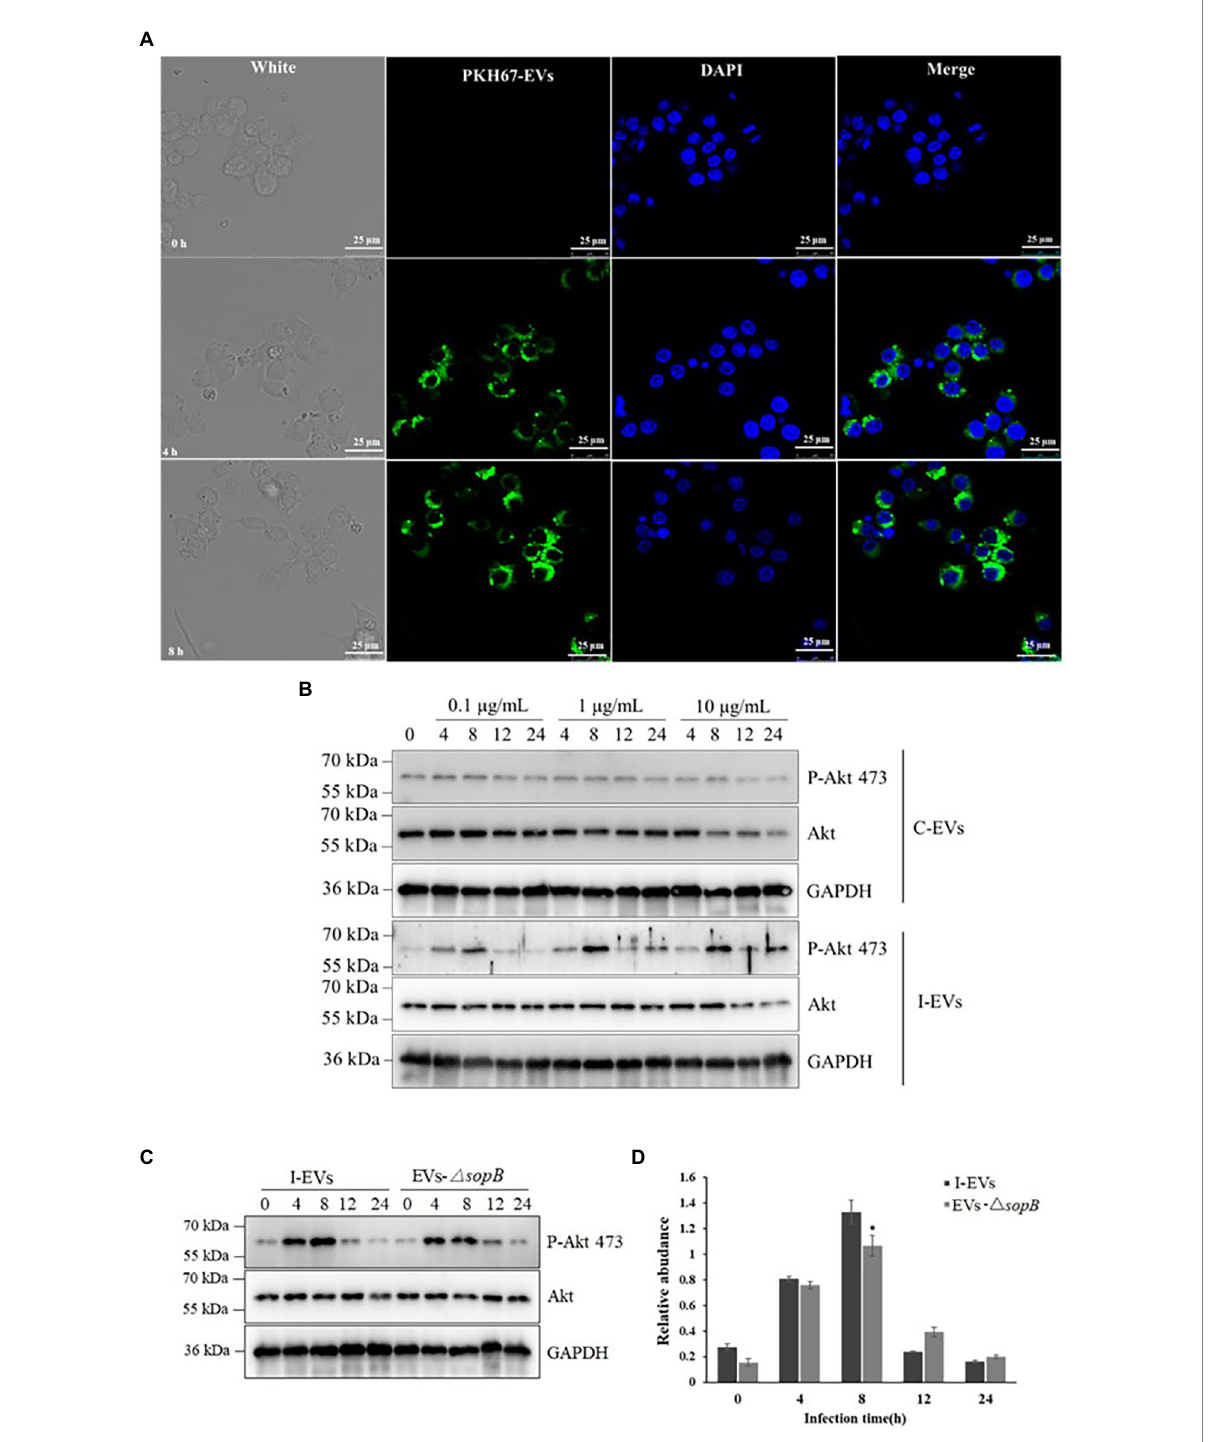
FIGURE 4 Functional verification of extracellular SopB taken up by RAW264.7 macrophages. (A) The RAW264.7 macrophages were incubated for 4 and 8 h ( n = 3). DAPI and PKH67 were used to stain the macrophages and extracellular vesicles, respectively. The scale bar is 25 μ m. (B) Phosphorylation of Akt at position 473 in RAW264.7 macrophages incubated with various concentrations of extracellular vesicles for different lengths of time. (C) Comparison of phosphorylation of Akt at position 473 in RAW264.7 macrophages incubated with extracellular vesicles prepared from Henle-407 cells infected with wild-type or Δ sopB mutant S . Typhimurium. (D) Densitometric quantification of the P-Akt 473/Akt ratio using c-Image. * P <